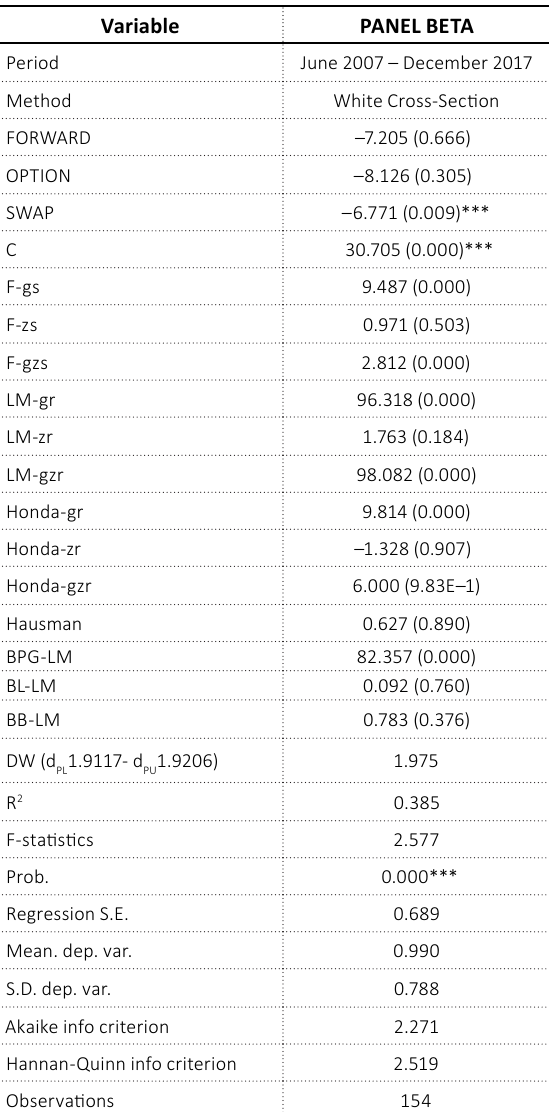
Table 11. The results of panel data